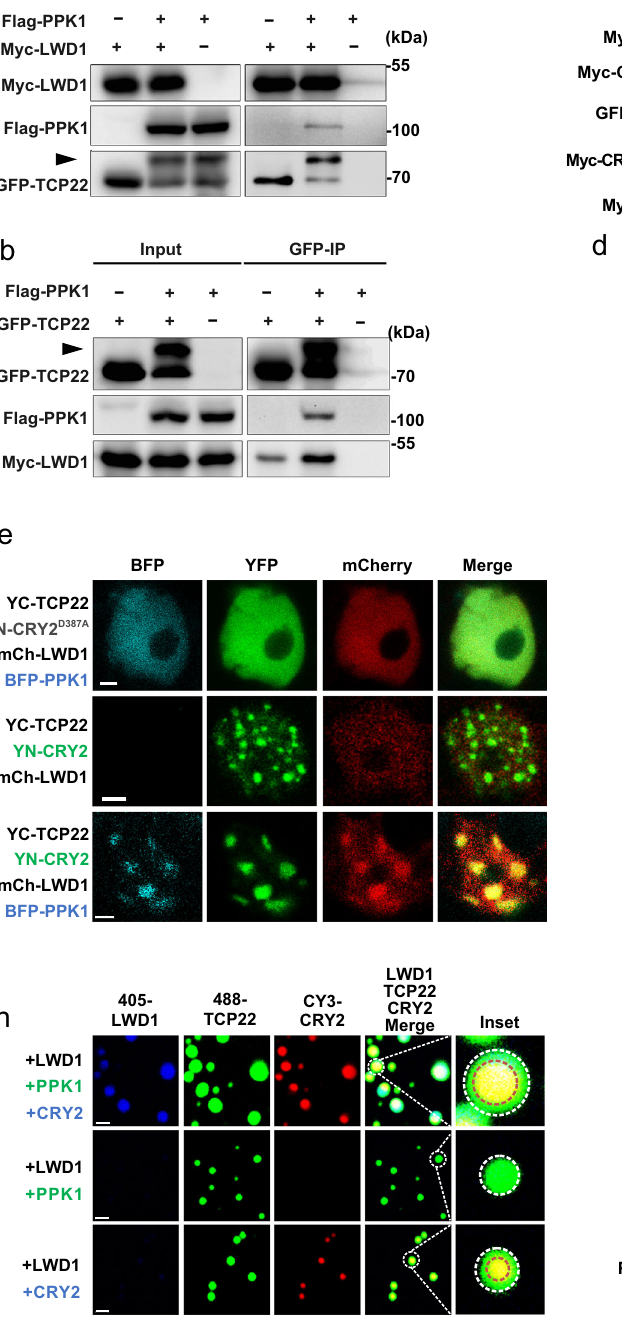
Ti plasmid was transformed into the Arabidopsis (Col), tcp20tcp22 or cry1cry2 using the fl oral-dip method 43 . The transgenic T1 populations were screened on composite soil irrigated with the 1 ‰ Basta solution (V/V) . The screened plants were grown in walk-in growth chambers at 22°C, 65% relative humidity under cool white fl uorescent tubes under Long-Day (LD) photoperiods (16 h light of 120 μ mol m − 2 s − 1 /8h dark).